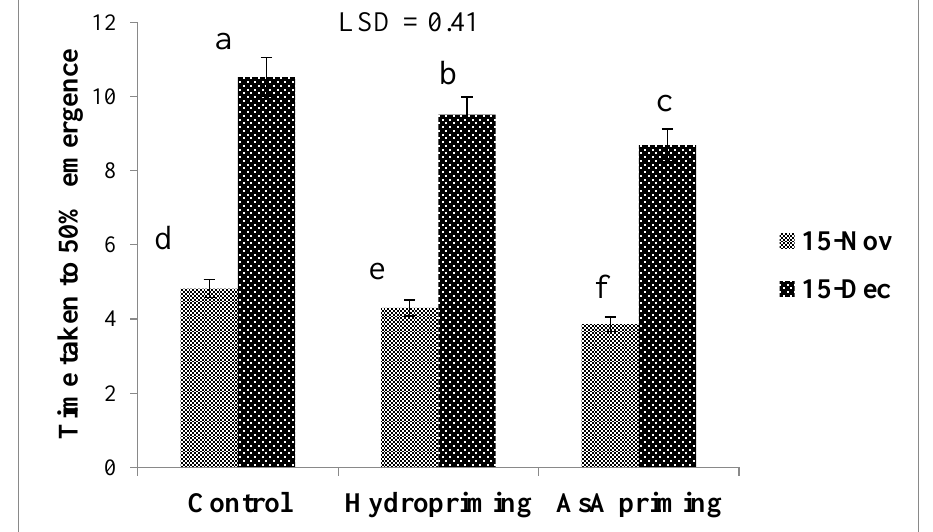
Figure 2. Interaction between priming techniques and sowing dates for time taken to 50% emergence during 2016. Means not sharing same letter (s) differ significantly at p ≤ 0.05.